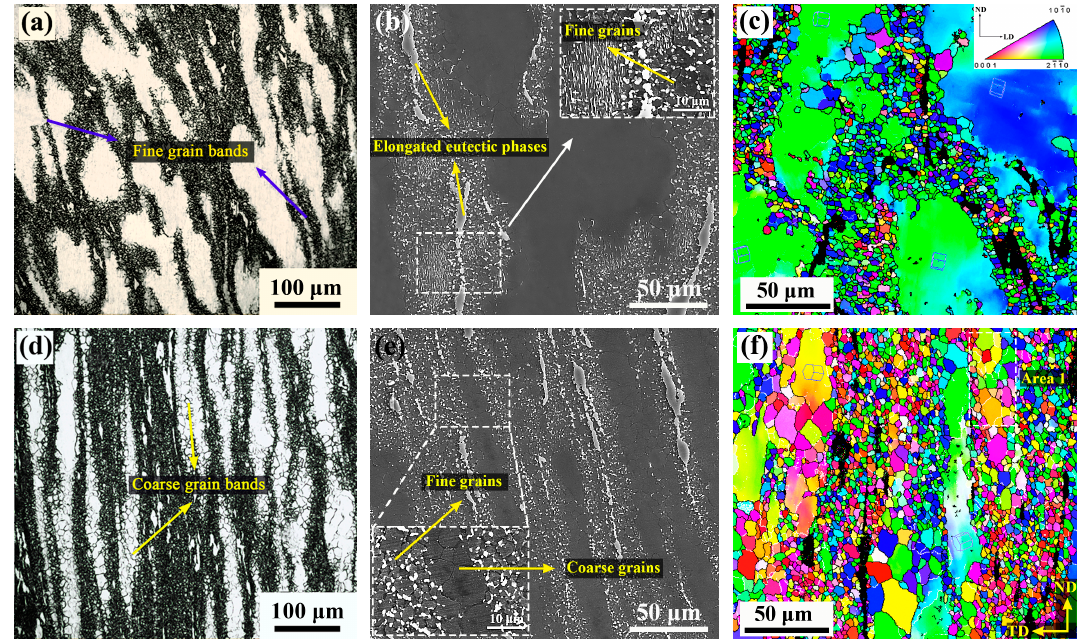
Figure 6. Microstructure of ( a – c ) zone B and ( d – f ) zone C: ( a , d ) OM, ( b , e ) SEM, and ( c , f ) EBSD, where the color key triangle shows the crystallographic orientation of HCP